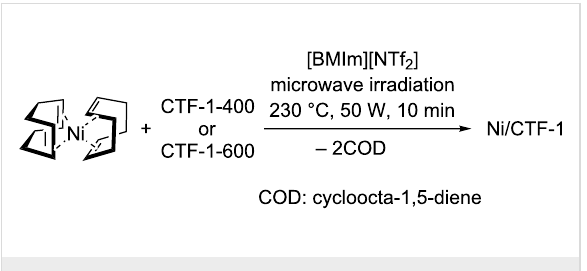
Figure 1: PXRD patterns of Ni/CTF-1 composite materials. The simu- lated diffractograms for hexagonal close-packed (hcp) and face- centered cubic (fcc) nickel are included, based on the crystallographic open database (CrOD)